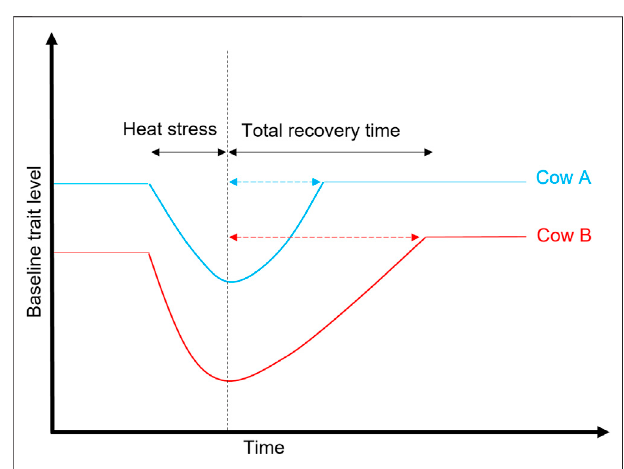
FIGURE 6 | Illustration of heat stress and recovery period between two cows: Cow A is more resilient to heat than Cow B because its trait (e.g., milk yield) returns to the baseline more quickly after exposure to heat stress or other environmental stressors (e.g., disease and